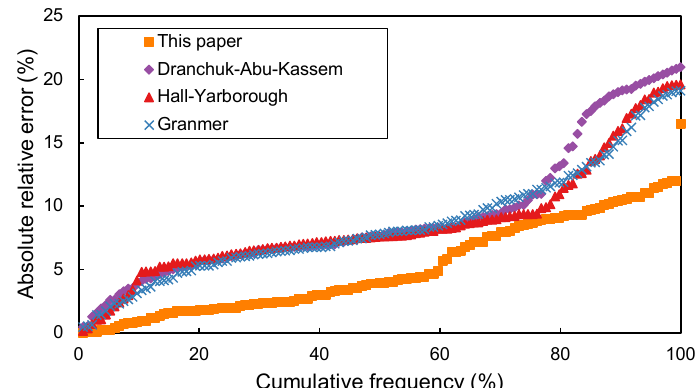
Figure 1. The absolute average error is computed by the four empirical methods as a function of cumulative